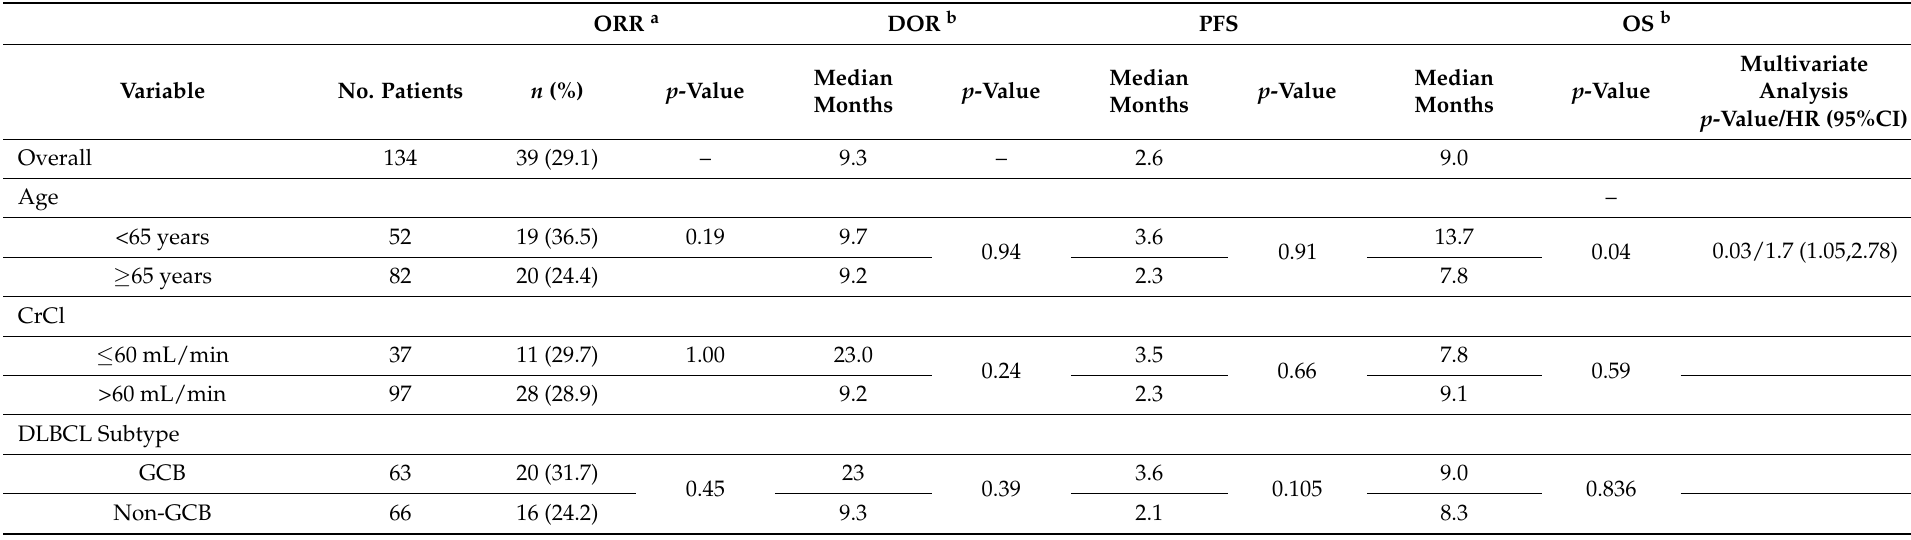
Table 2. Efficacy of selinexor based on baseline characteristics in the mITT